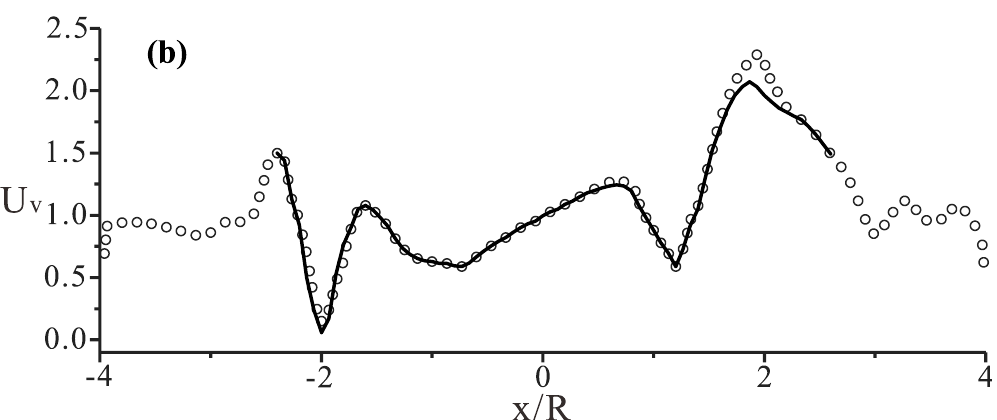
Figure 12. Displacement amplification ratios of ground under incident SV-waves with angle of 25°: ( a ) horizontal ratios and ( b ) vertical ratios (solid lines are analytical solutions by Wong [60] and circles are numerical results of finite element method based on ABAQUS).